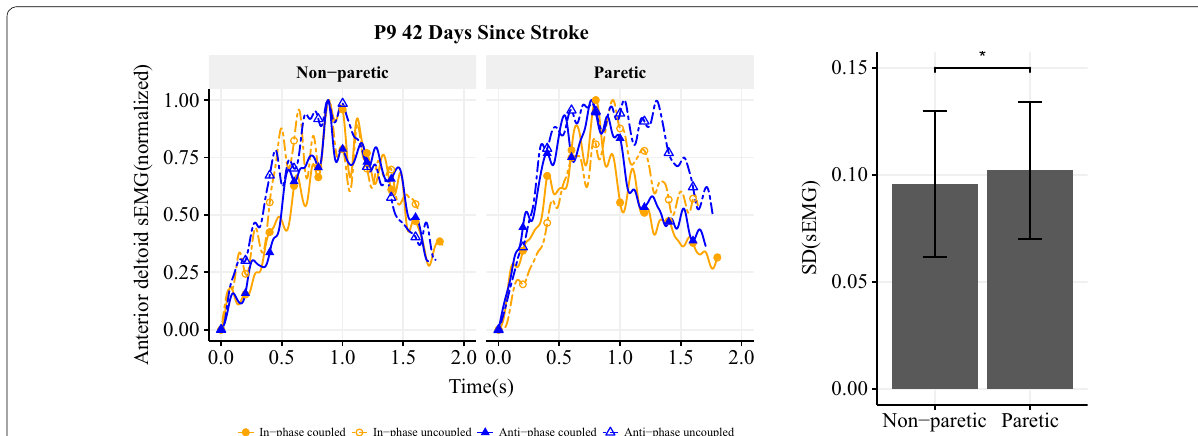
Fig. 5 a Example EMG profiles of the anterior deltoid muscles in different tasks during upwards motion. These profiles show that the anterior deltoid muscle of the non-paretic arm was activated in almost the same way across the four different types of bimanual motion, while the corresponding muscle of the paretic arm was activated in different ways depending on the type of bimanual motion. b Statistical analysis of the variability of muscle activities on the non-paretic and paretic arms across all patients’ trials. There was significantly higher dispersion for muscle activation of the paretic arms. The bars represent means, with whiskers representing ±